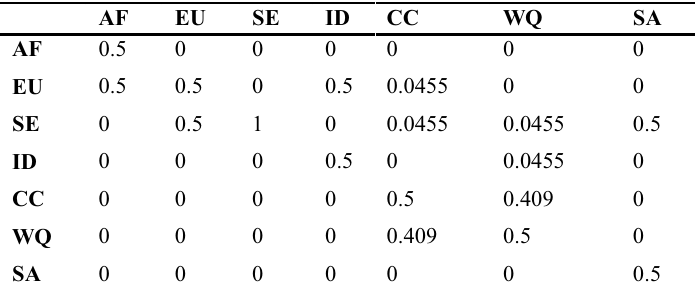
Table 5: Degree of relative impact of evaluation